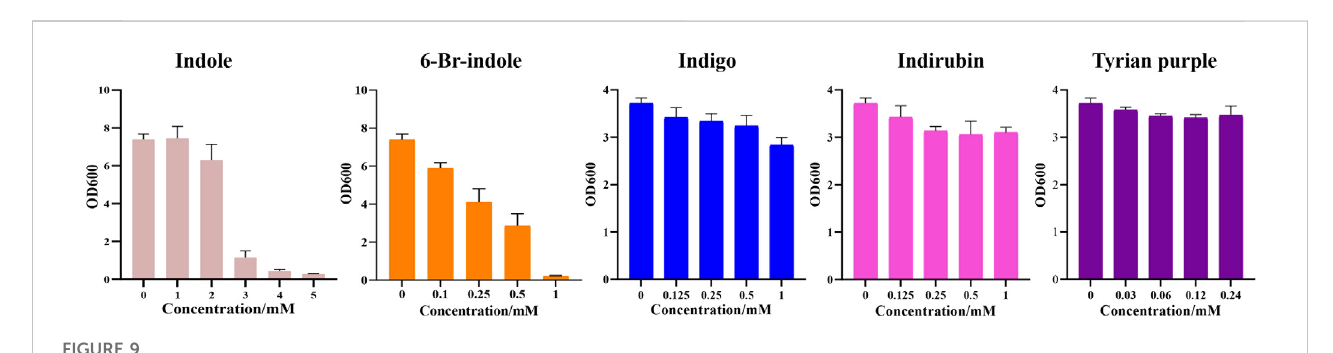
Frontiers in Bioengineering and